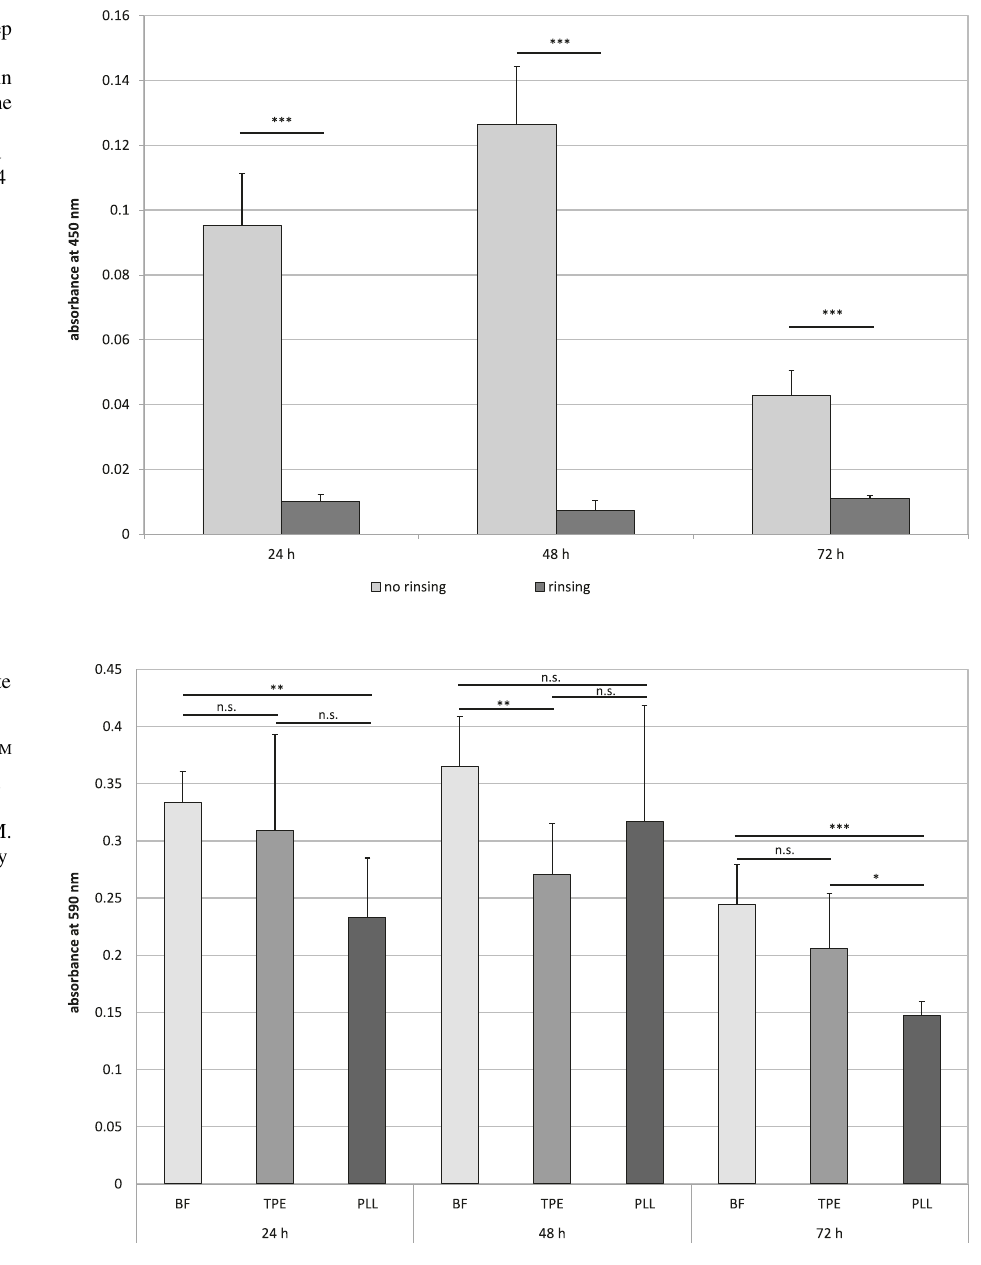
Fig. 7 In fl uence of the substrate on formation of P. fl uorescens bio fi lm during 72 h incubation on boro fl oat glass (BF), Nunc TM Thermanox TM polyester (TPE), and poly-L-lysin coated coverslips (PLL) in 1:100 LBM. Bio fi lm mass was quanti fi ed by crystal violet staining and subsequent absorbance measurement at 590 nm. Data are given as mean ± standard